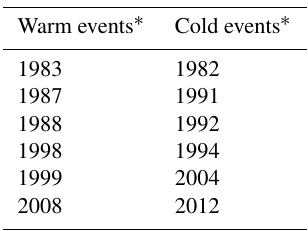
Table 1. Warm and cold SST events in the marginal seas of East Asia in austral spring during the period from 1979 to 2015 analyzed in this paper using the ST_MSEAI (Fig. 3a).